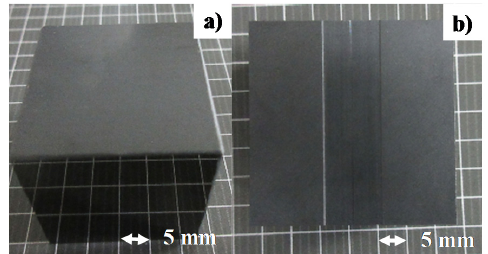
Figure 1. SiC-coated SiC punch and die. ( a ) SiC-coated SiC punch, and ( b ) SiC-coated SiC die with a rectangular cavity.